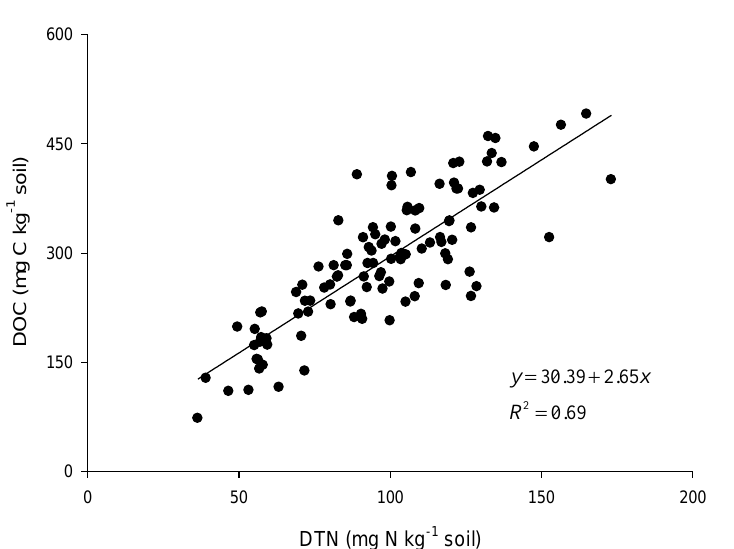
Figure A3. Correlation between DOC and DTN in the study area.